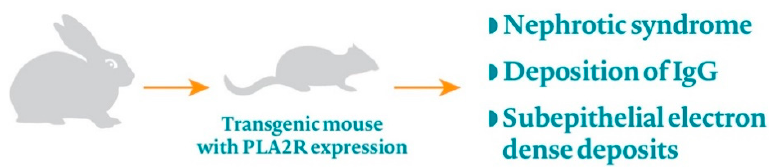
Figure 1. A study by Meyer-Schweinger and Tomas proved that antibodies against phospholipase A2 associated receptor 1 (PLA2R) cause primary membranous nephropathy. Immunoglobulin G